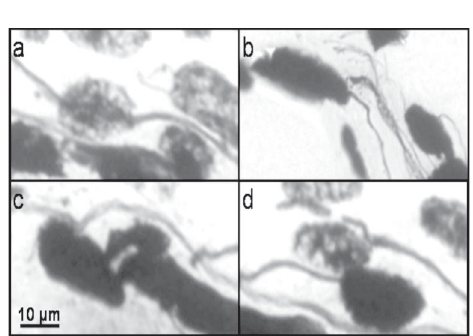
Figure 6. Detection of a periph- eral nerve at the site of ectopic skeletal muscle fibers. Fourteen days after transplantation of sat- ellite cells, the allografts were submitted to peripheral nerve staining (stained in black, a-d).